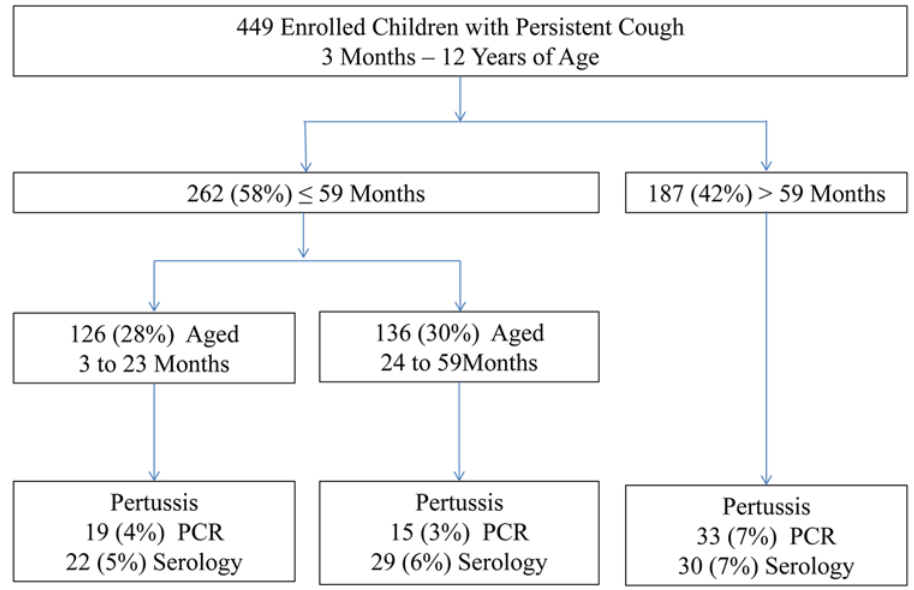
Fig 1. Study Flow Chart of Enrolled Participants According to Age at Mulago National Referral Teaching Hospital in Kampala, Uganda (n = 449).